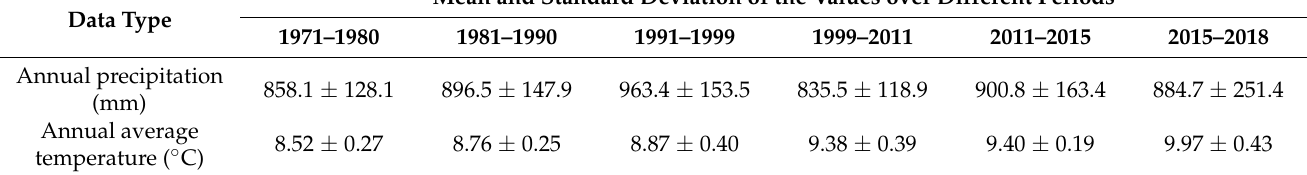
Table 4. Annual precipitation and annual average temperature recorded at the Bomi meteorological station from 1971 to